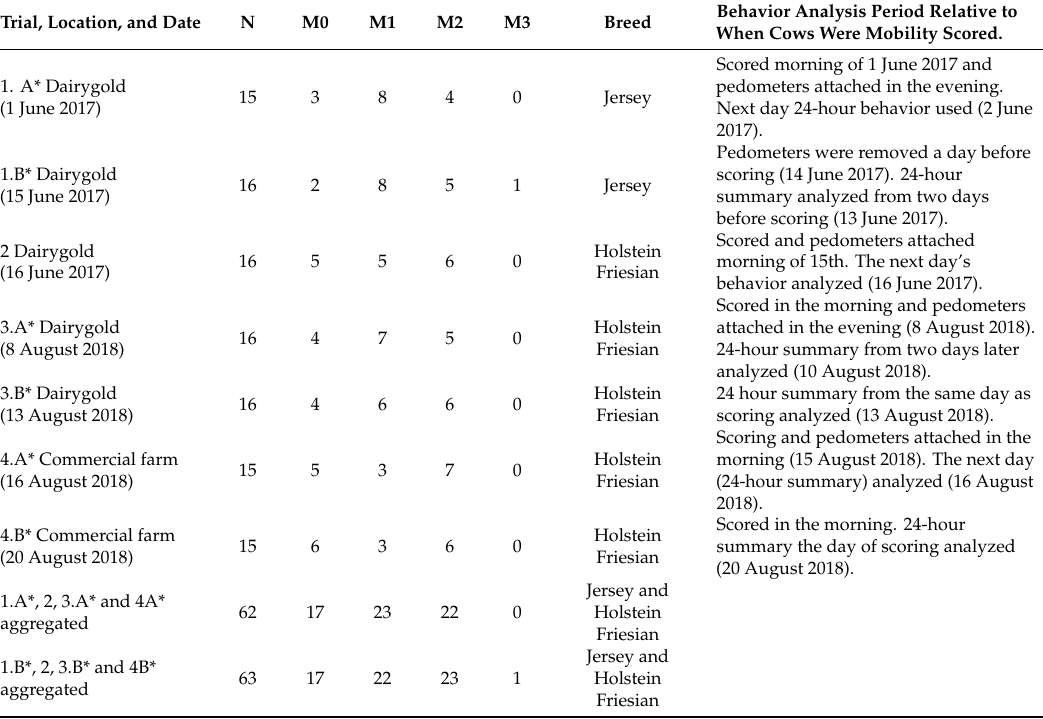
Table 1. Trial descriptions. N is the number of datasets from each locomotion scoring event. M relates to the mobility score and the number of available datasets from cows of each score.